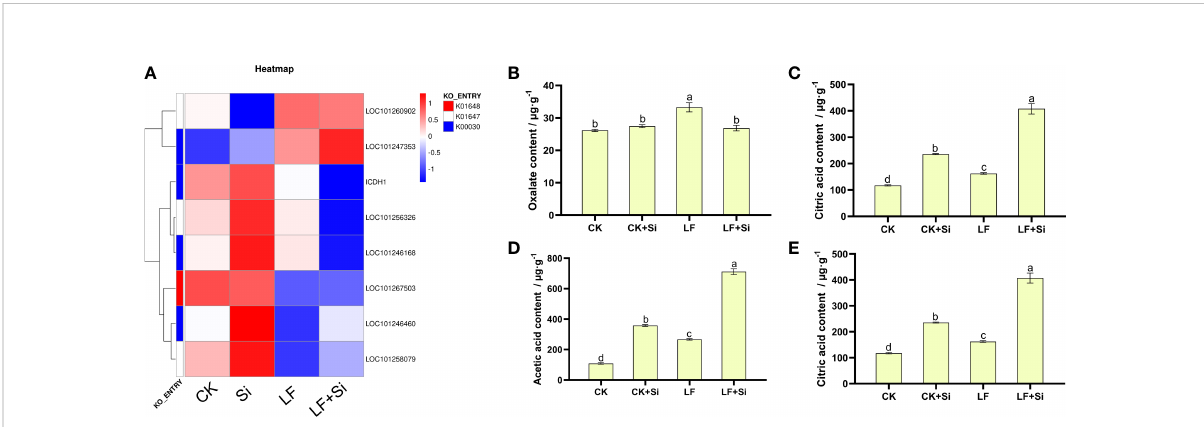
FIGURE 6 Effects of silicon application on organic acid metabolism in tomato roots under Fe de fi ciency. (A) Heat map of related differentially expressed genes. (B) Oxalate content. (C) Malic acid content. (D) Acetic acid content. (E) Citric acid content. Each data point represents the mean of three independent biological replicates (mean ± SD). Different letters above the bars indicate statistically signi fi cant differences ( P